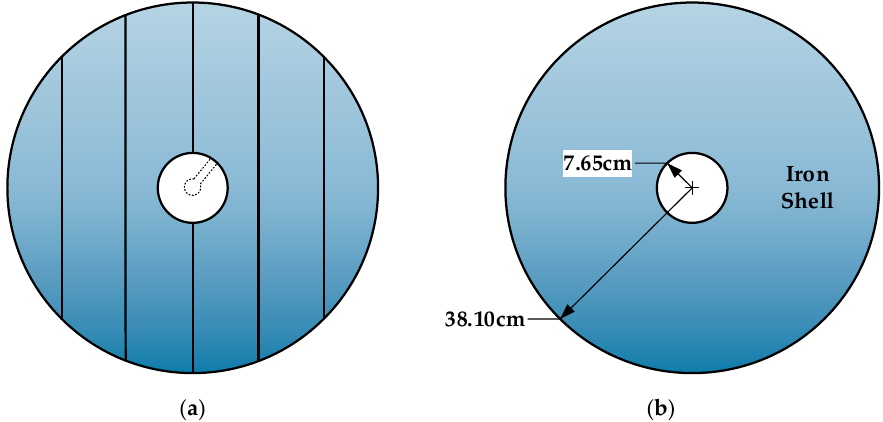
Figure 4. Geometry of ill_fe iron sphere benchmark. ( a ) Simplified geometry of experimental device. The solid line represents the surface of the assembled parts which are combined into a spherical device. The reentrant hole, which is used to place the DT neutron source, is represented by the dashed line in the central void region. ( b ) Simpli fi ed geometry used in one-dimensional S N calcula- tion.